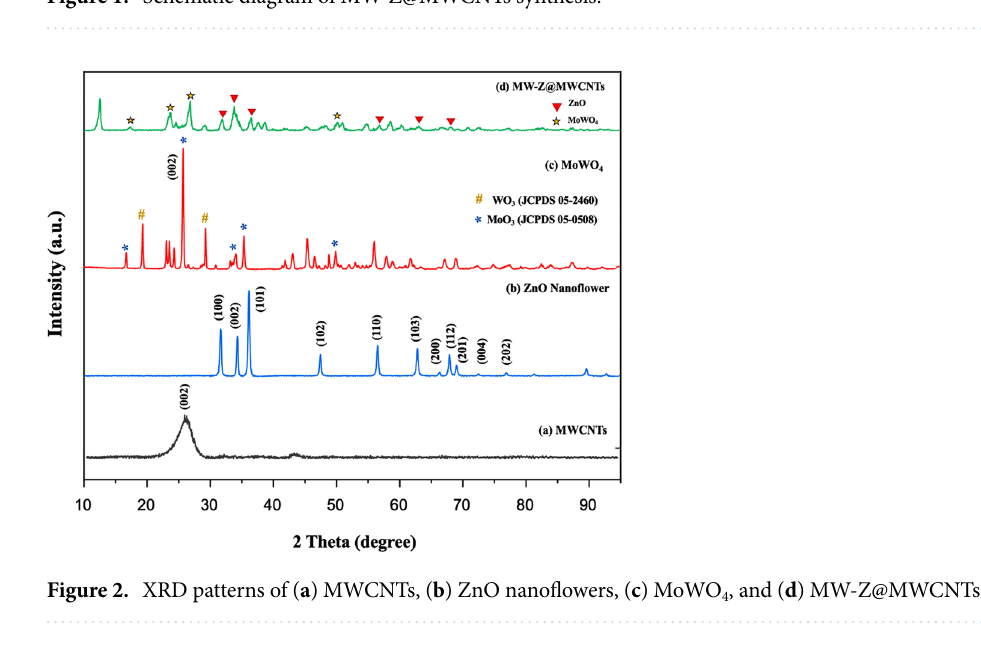
Figure 1. Schematic diagram of MW-Z@MWCNTs synthesis.